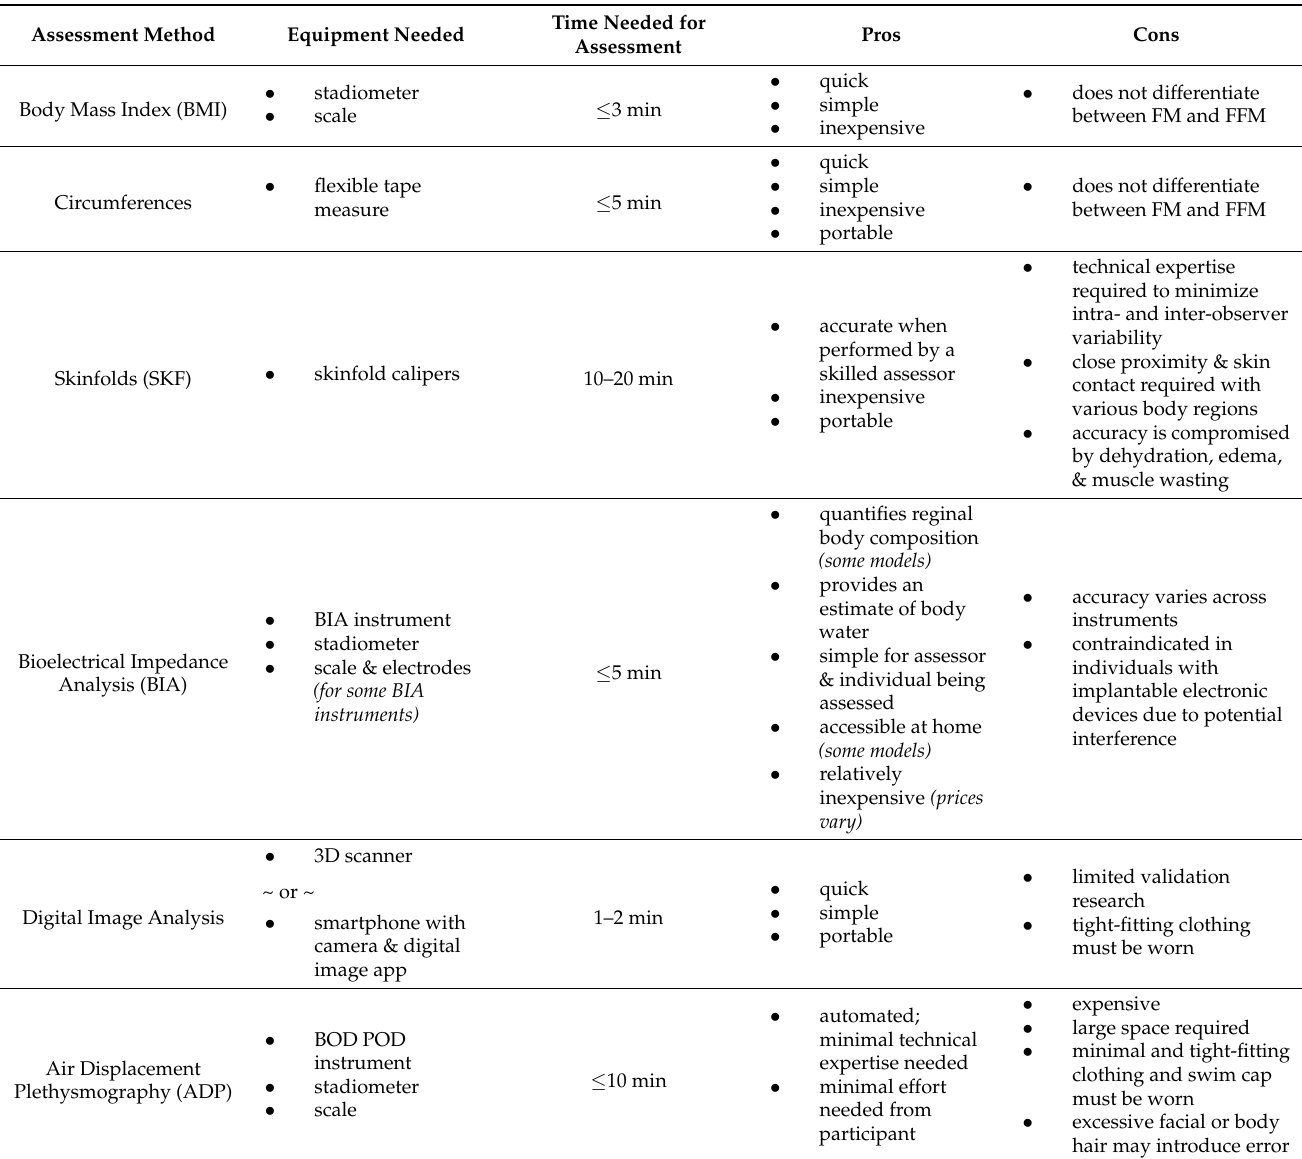
Table 2. Overview of Body Composition Assessment Technique Requirements, Pros, and